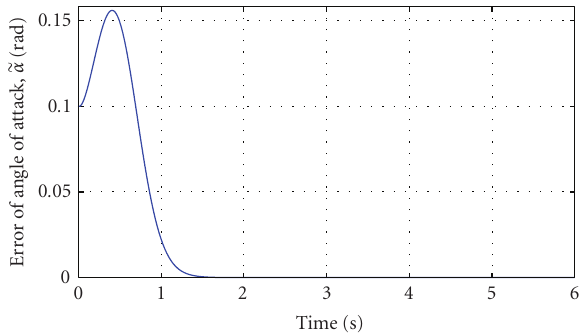
Figure 9: Tracking error for observer (cid:20) α = (cid:9) α − α.